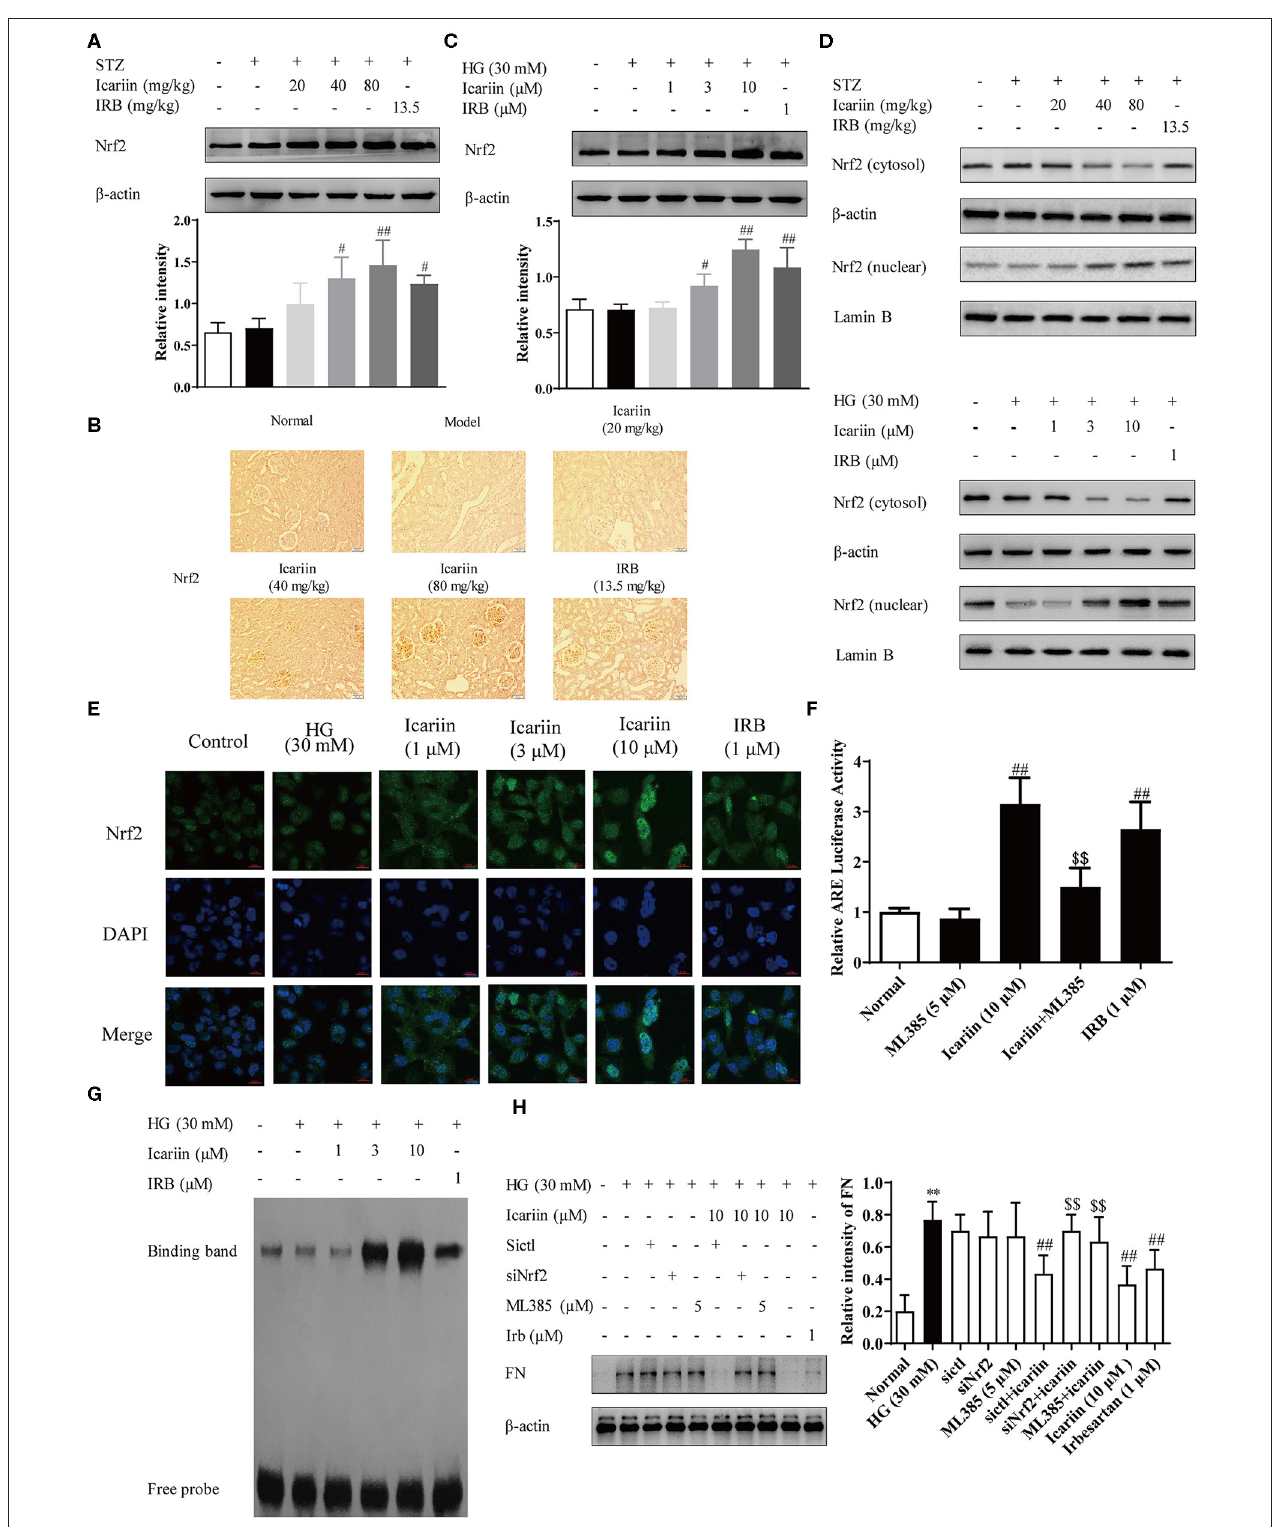
FIGURE 7 | Effect of icariin on Nrf2 activation and ECM generation in DN rats and HMC induced by high glucose. (A) Effect of icariin on the total expressions of Nrf2 in DN rats was detected by western blot assy. (B) Effect of icariin on Nrf2 protein level in DN rats was detected by immunohistochemical staining. Scale bar: 50 µ m